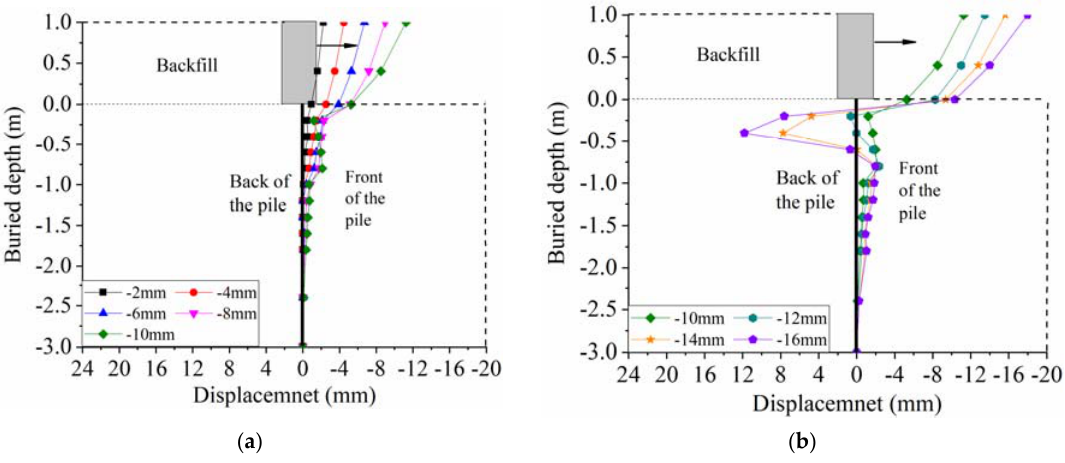
Figure 23. Distribution of horizontal deformation of specimen under negative displacement loads. ( a ) Under displacement loads of − 2 mm~ − 10 mm. ( b ) Under displacement loads of − 10 mm~ − 16 mm.